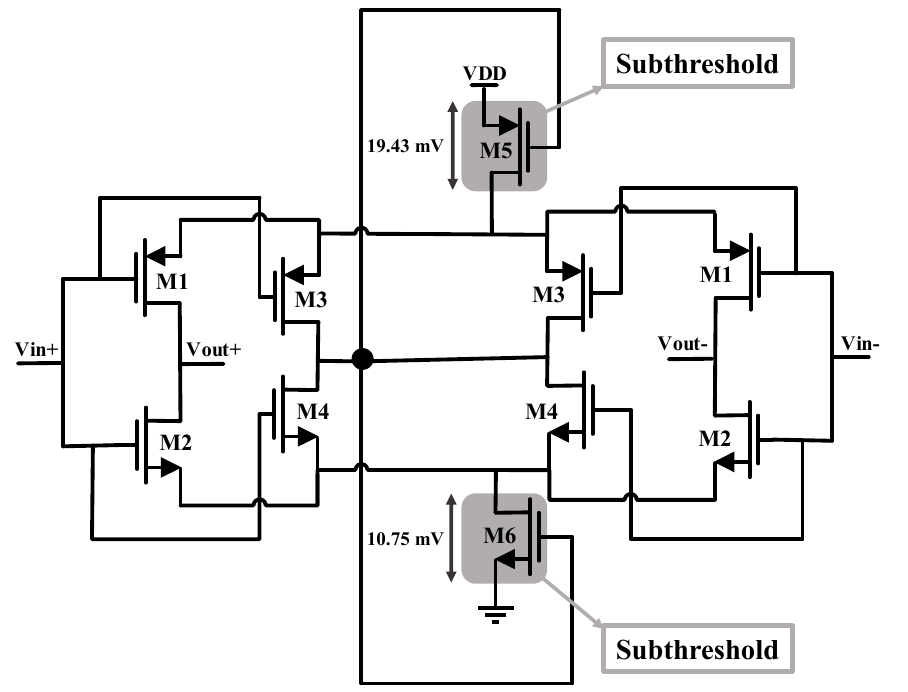
Figure 5. The proposed robust self-biased differential inverter-base amplifier. Table 3. The aspect of the ratio of the proposed ampli fi er transistors.